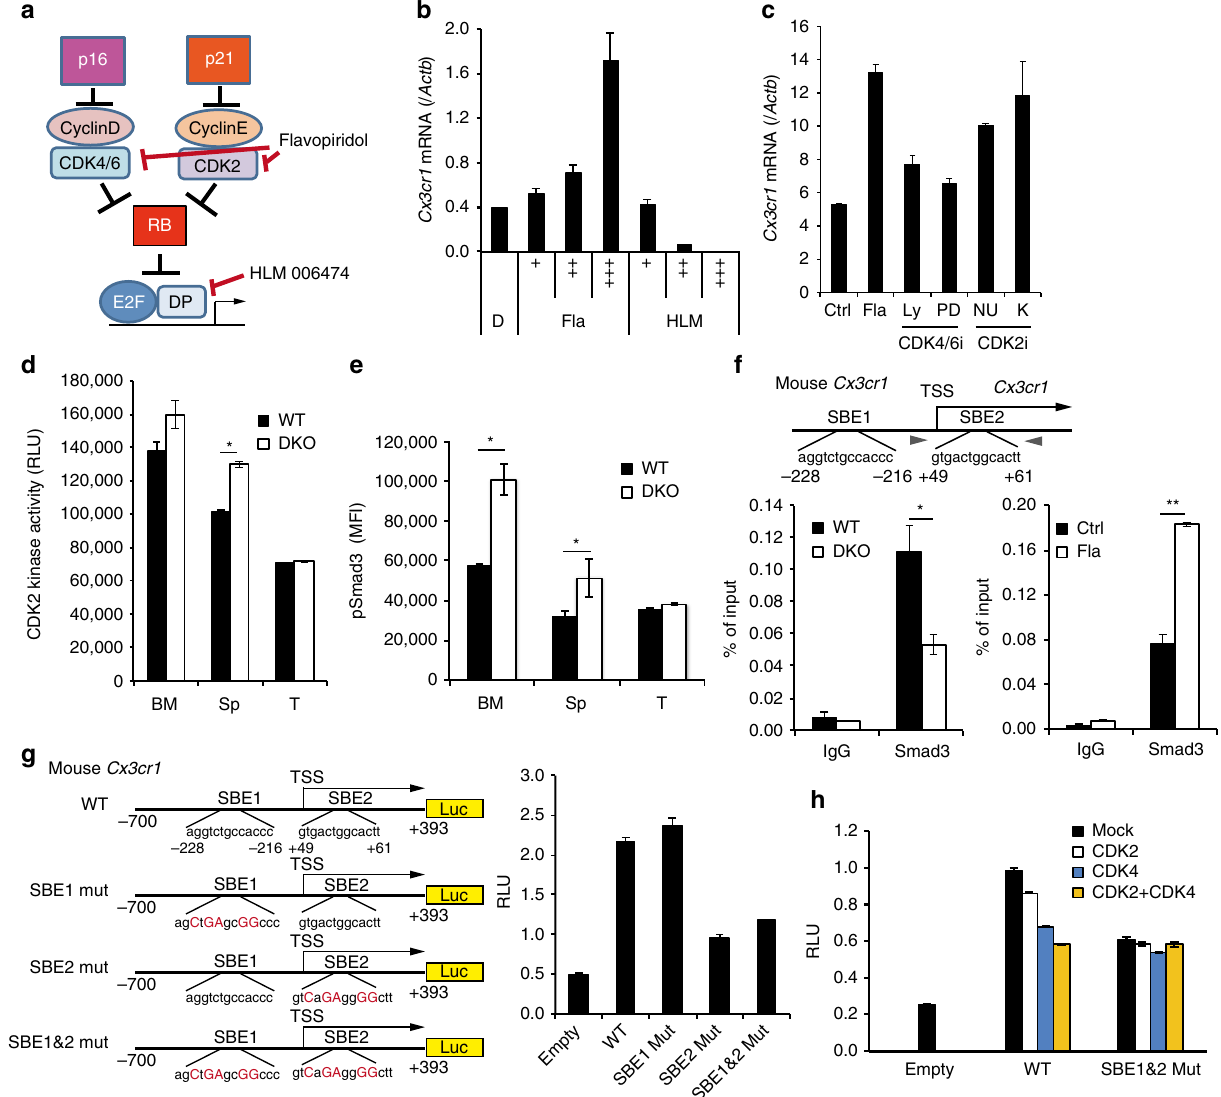
Fig. 5 CDK-mediated SMAD3 phosphorylation inhibits Cx3cr1 expression. a Diagram of the CDKI-CDK-RB-E2F pathway and sites of action of chemical inhibitors. b Expression of Cx3cr1 mRNA in BM-Mo-MDSCs treated with indicated doses of fl avopiridol (Fla), HLM006474 (HLM) or dimethyl sulfoxide (DMSO) control (D). b “ + ” indicates drug concentration: Fla; + (4 nM), ++ (20 nM), +++ (100 nM). HLM; + (2 nM), ++ (10 nM), +++ (50 nM). c Expression of Cx3cr1 mRNA in BM-Mo-MDSCs treated with fl avopiridol (Fla; 50 nM), LY2835219 (Ly; 5 nM), PD 0332991 (PD; 5 nM), NU6027 (NU; 5 μ M), K03861 (K; 250 nM) or DMSO (Ctrl). d Kinase activity of CDK2 against recombinant SMAD3. CDK2 was immunoprecipitated from lysates of